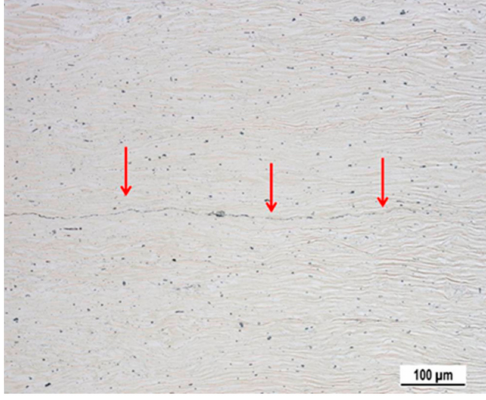
Figure 4. New interface formed in the ARB_1 sample.